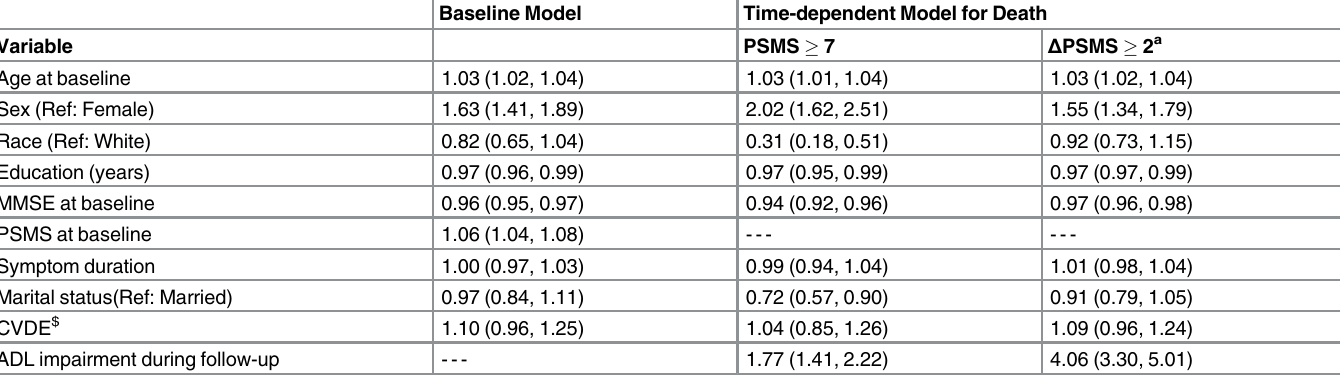
Table 2. Hazard ratios (95% confidence intervals) in the baseline Cox regression model and time-dependent Cox regression models for death.